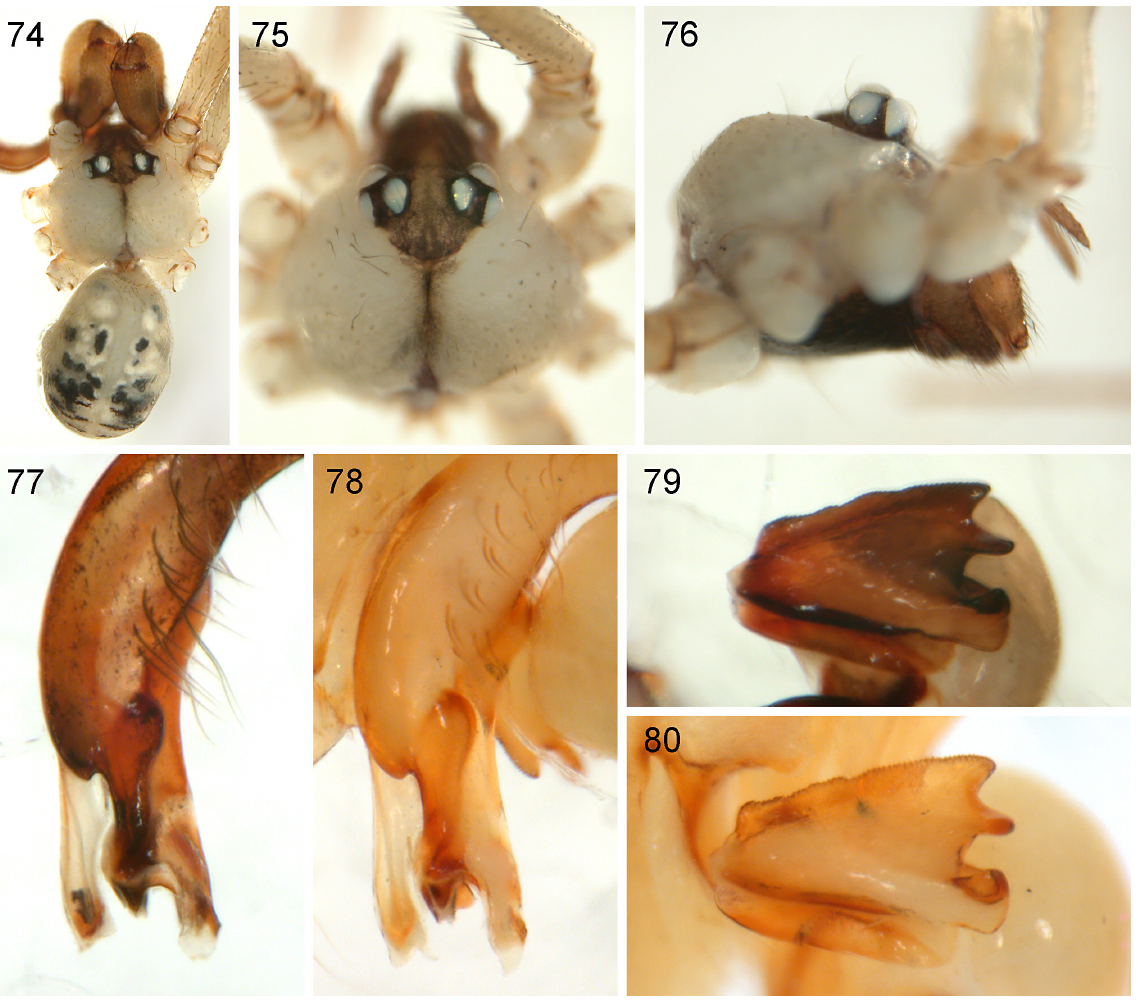
Figs 74–80. Savarna miser (Bristowe, 1952). 74 . ♂ from Batu Caves, dorsal view. 75–76 . ♀ from Batu Caves, prosoma in dorsal and lateral views. 77–78 . Right procursi, retrolateral views, ♂♂ from Batu Caves (77) and from cave near Baso (holotype of Spermophora baso Roewer, 1963; 78). 79–80 . Right bulbal processes, ♂♂ from Batu Caves (79) and from cave near Baso (holotype of Spermophora baso Roewer, 1963; 80). At varying